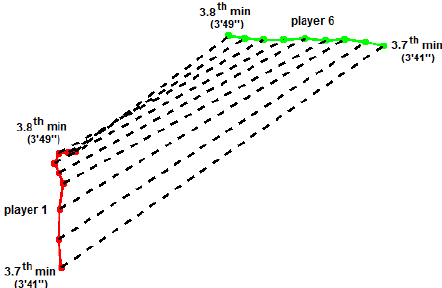
Figure 6. The trajectories of player 1 and player 6 during time interval [3.7, 3.8] min.